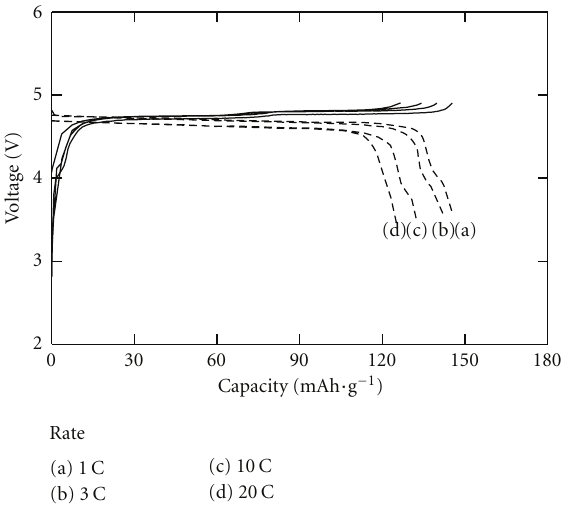
Figure 7: Relation between discharge capacity and cycle number at rate indicated.